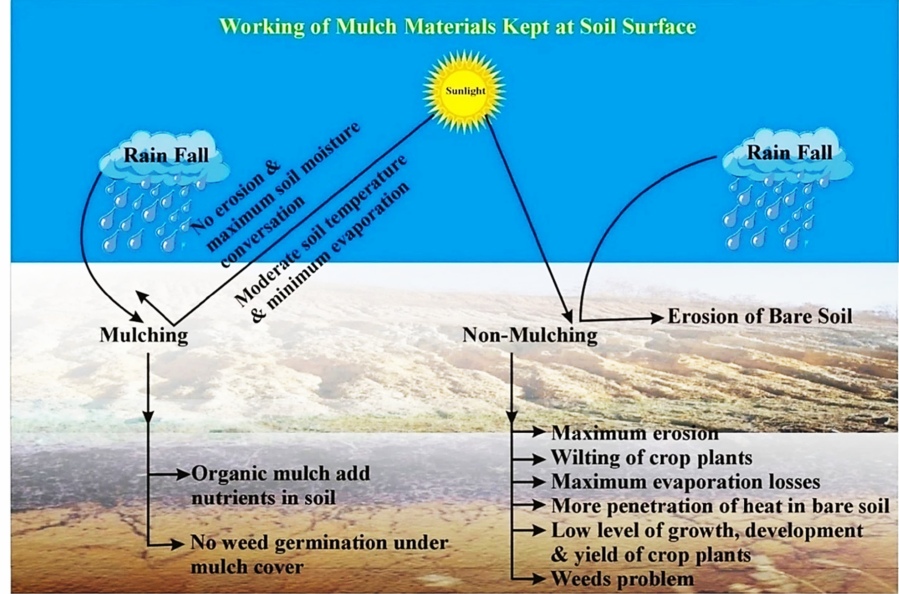
Figure 5. The effects between mulching and non-mulching.